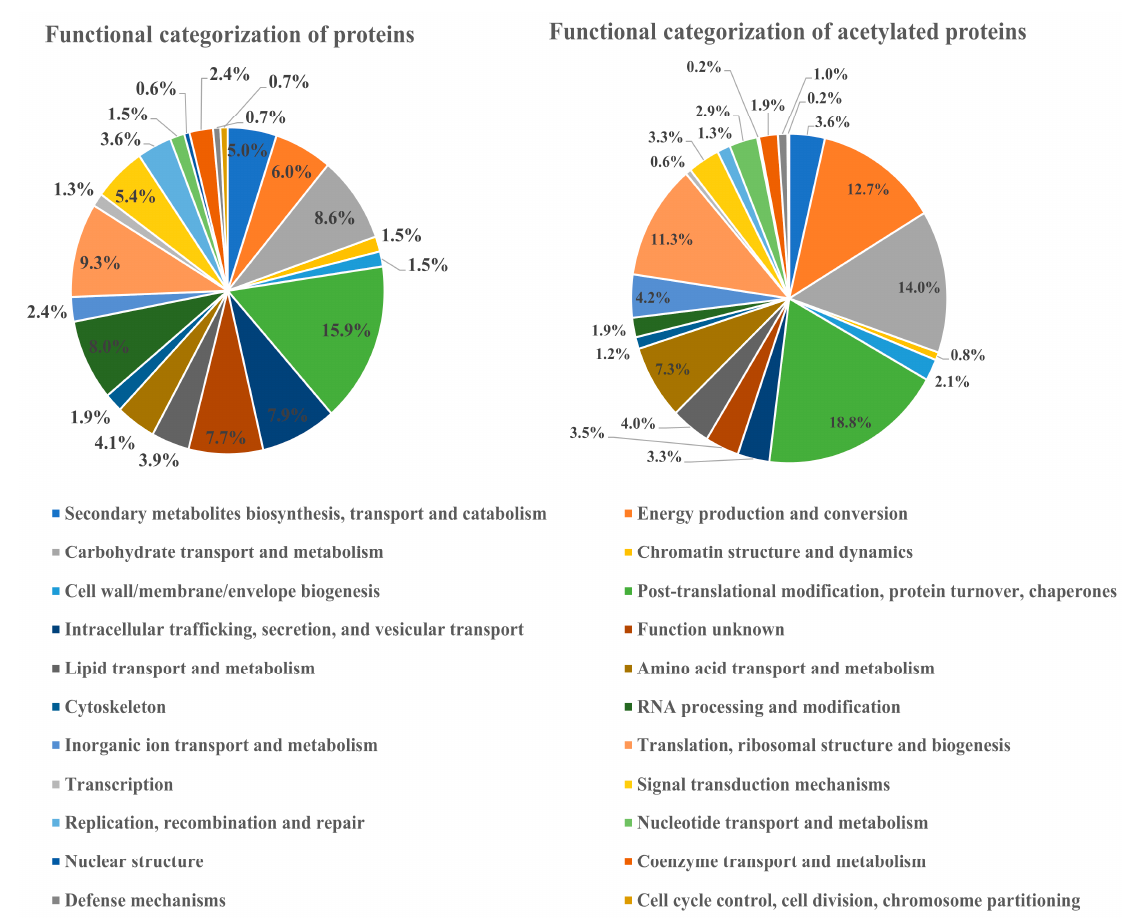
Figure 2. Quantity of differential proteins and acetylated proteins of Rhododendron chrysanthum under UV-B stress. ( A ) Number of differentially expressed proteins; ( B ) number of differentially acetylated proteins and sites.